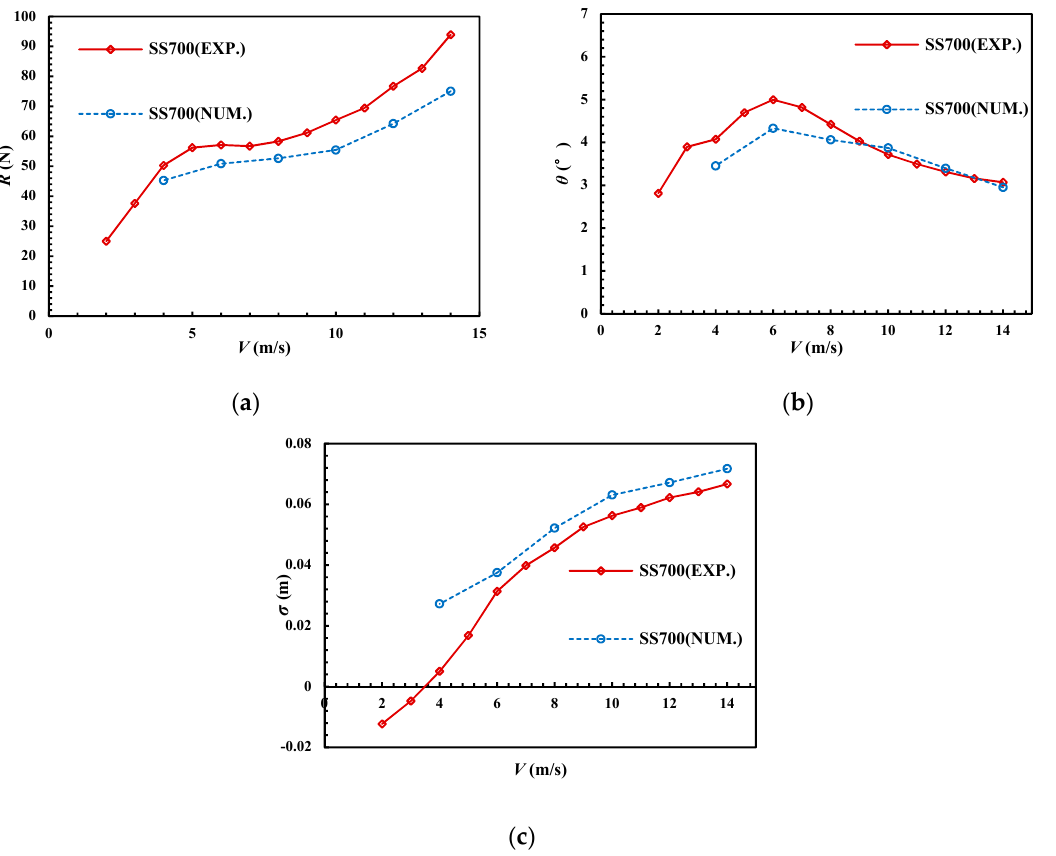
Figure 6. Mesh generation strategy and mesh convergence study for full scale numerical simulation: ( a ) Resistance; ( b ) Trim angle; ( c ) Sinkage.